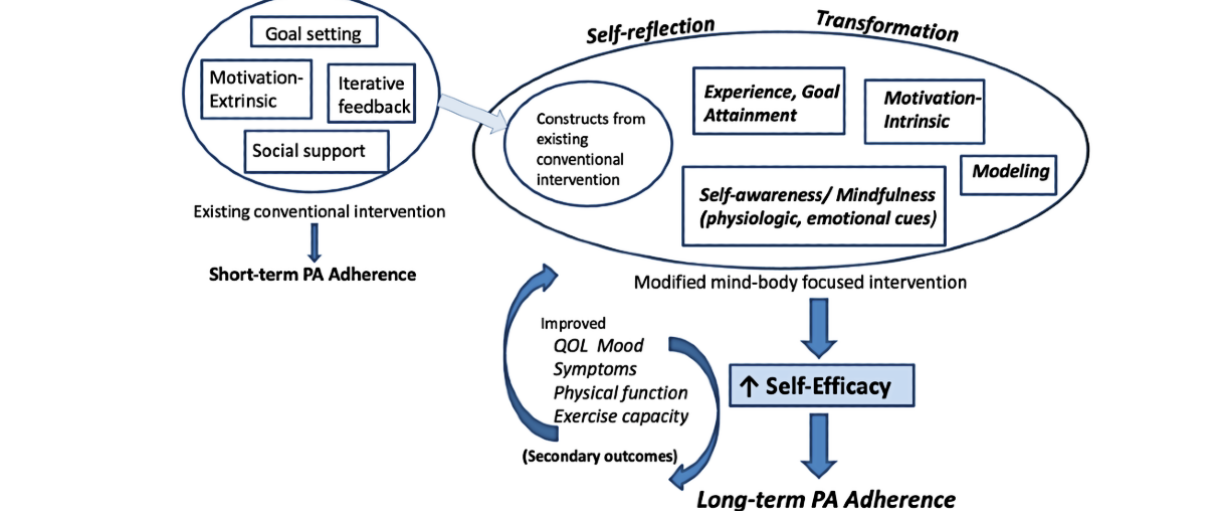
Figure 1. Conceptual model. PA; physical activity; QOL: quality of